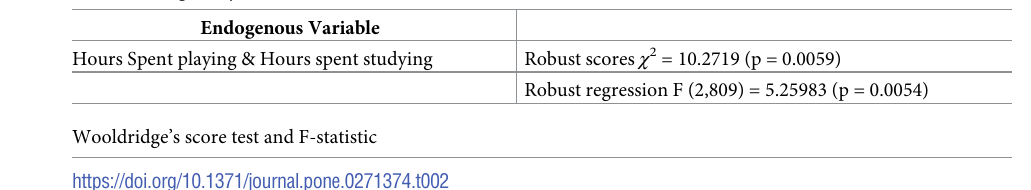
Table 2. Exogeneity test for PPVT